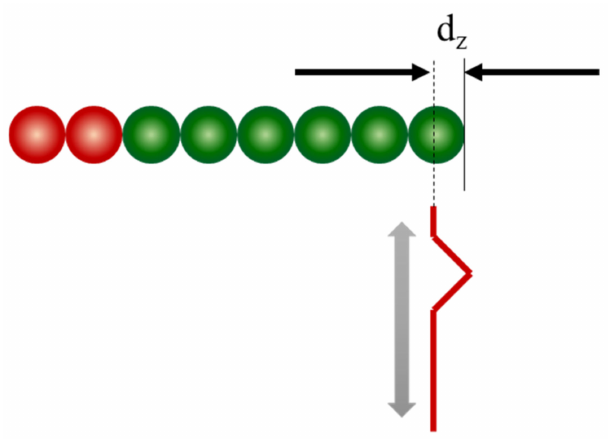
Figure 4. Schematic of brushing depth.